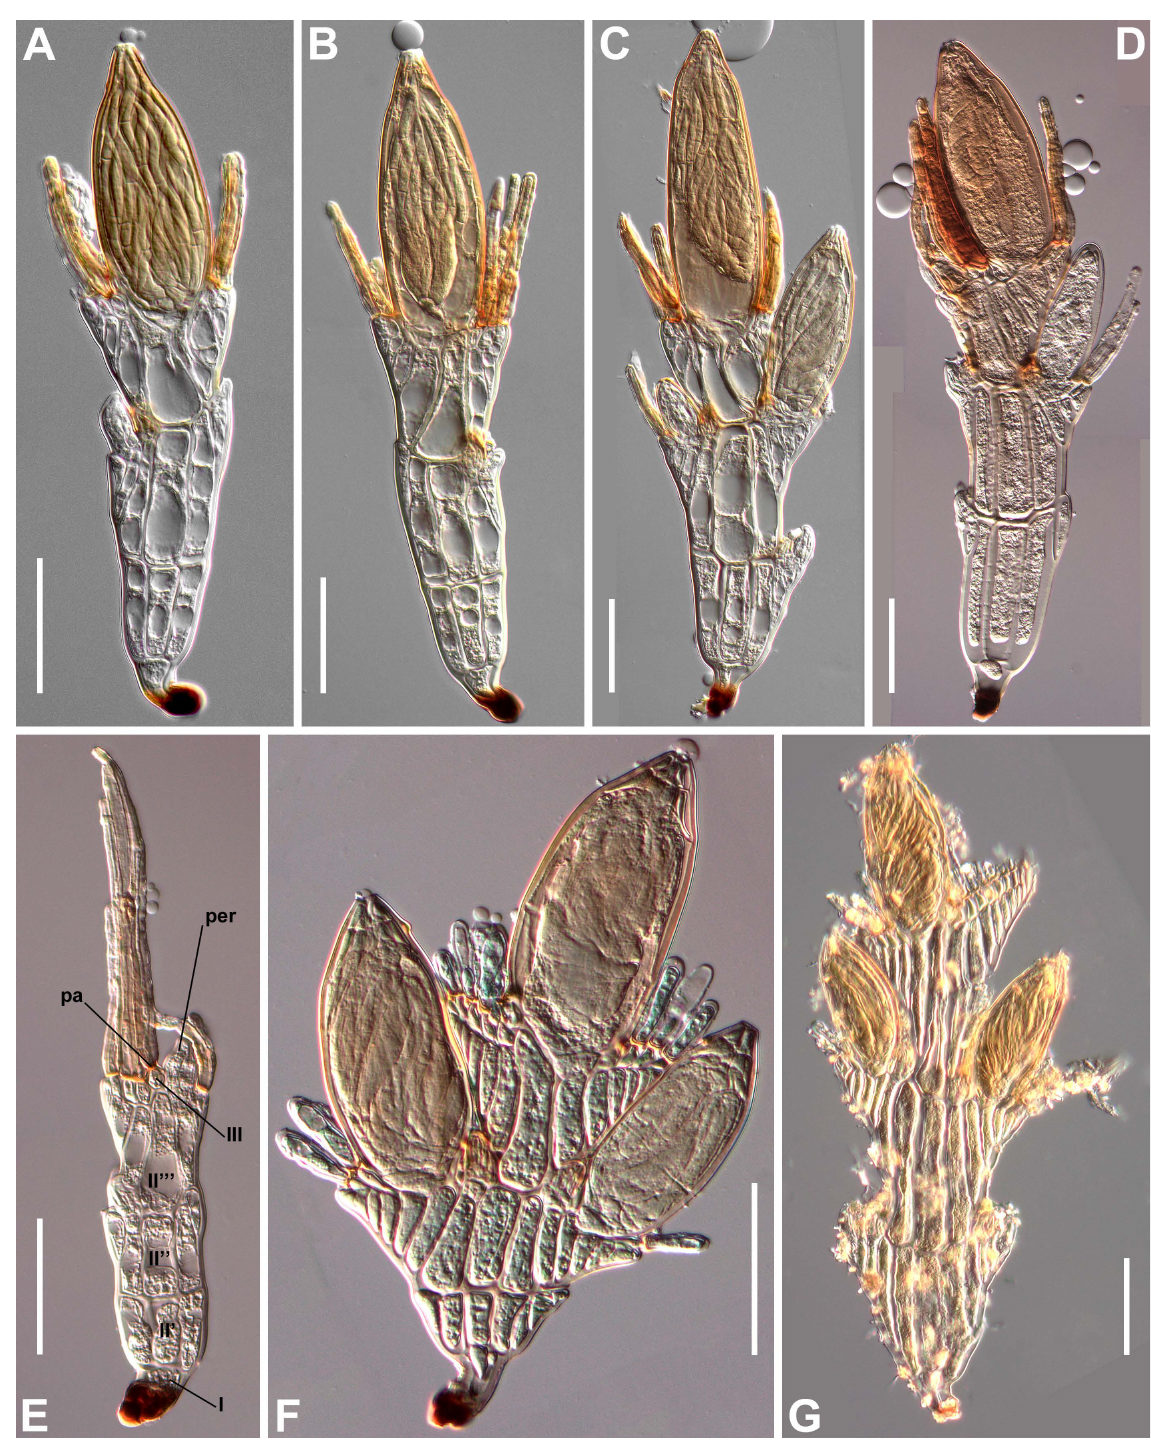
Fig. 68. Peyritschiella spp. A – E . P. oxyteli (Cépède & F.Picard) Santam. comb. nov. A – D . Mature thalli. E . Immature thallus with labelling of cells I, II’, II”; II’’’, III, primary appendage (pa), and perithecium initial (per). – F – G . P. protea Thaxt. F . Mature thallus from Bledius in Spain. G . Mature thallus from type slide kept in FH. Scale bars: 50 µm. Photographs from slides ZMUC C-F-122472 (A–C) (neotype), ZMUC C-F-122702 (D), ZMUC C-F-122809 (E), BCB-SS2016 (F), FH2590 (G)